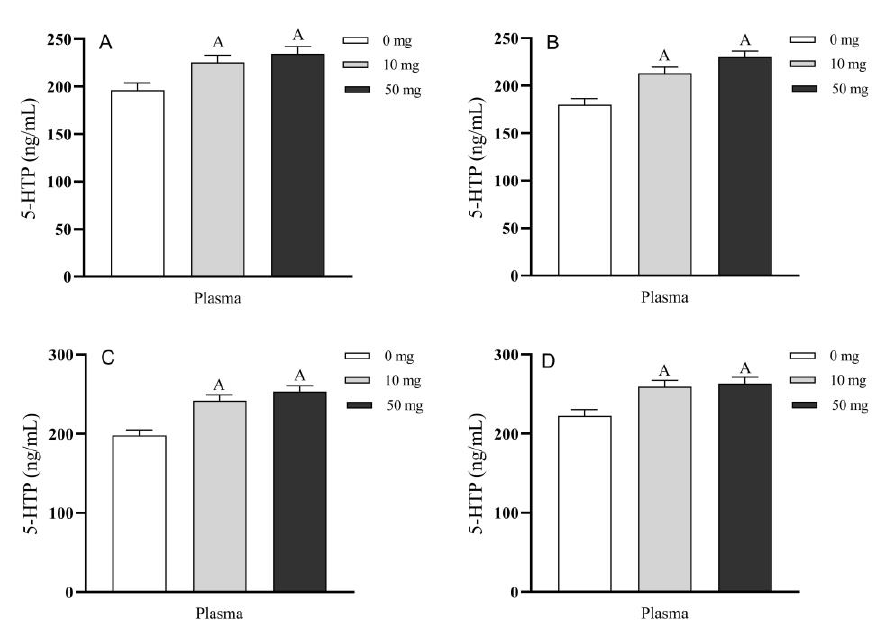
Figure 4. Effects of different doses of 5-HTP duodenal perfusion on blood 5-HTP levels of different blood vessels. ( A ) portal vein, ( B ) carotid artery, ( C ) jugular vein and ( D ) posterior vena cava. The data were expressed as LSM ± SEM ( n = 6). The capital letters indicate p < 0.01 vs. control.